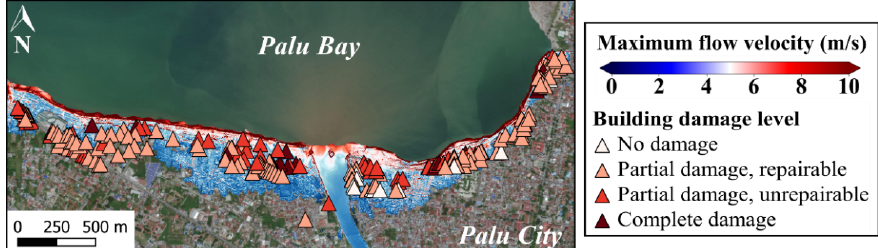
Figure C3. Sulawesi–Palu final tsunami inundation model with the maximum simulated flow velocity overlaid on the damaged building data (background ESRI).